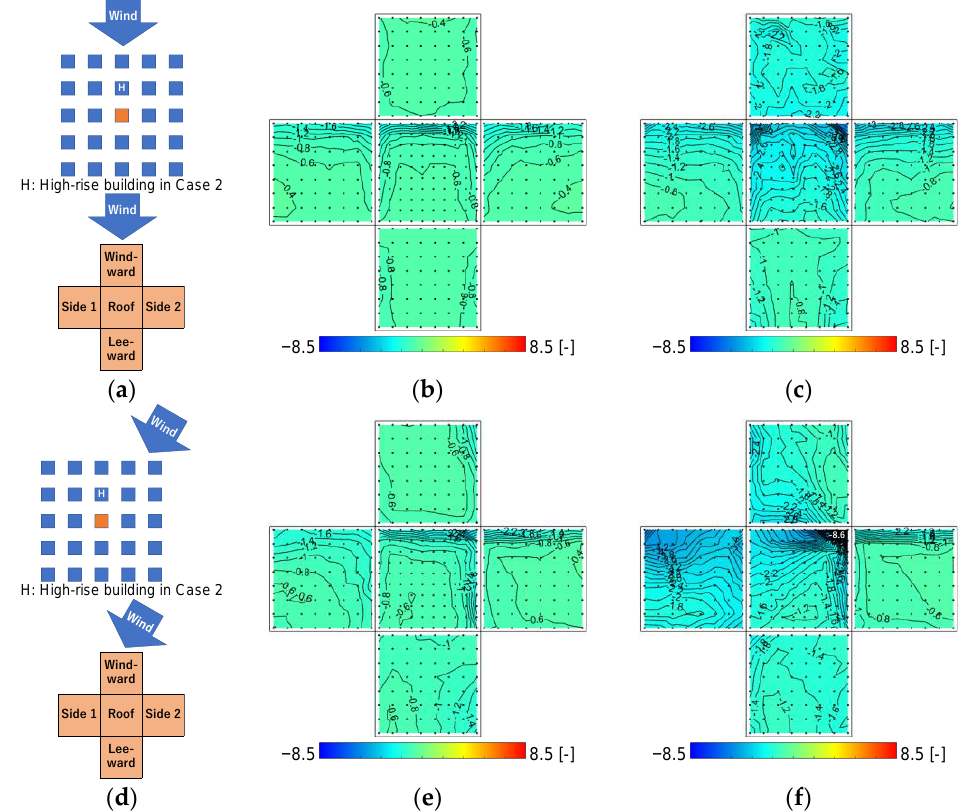
Figure 9. Negative 𝑝𝑒𝑎𝑘𝐶 𝑝 ; ( a ) building model arrangement and prevailing wind direction for ( b , c ); ( b ) wind direction of 0° in Case 0 with no high-rise building; ( c ) wind direction of 0° in Case 2 with a high-rise building next to the pressure measurement model; ( d ) building model arrangement and prevailing wind direction for ( e , f ); ( e ) wind direction of 30° in Case 0; ( f ) wind direction of 30° in Case 2.